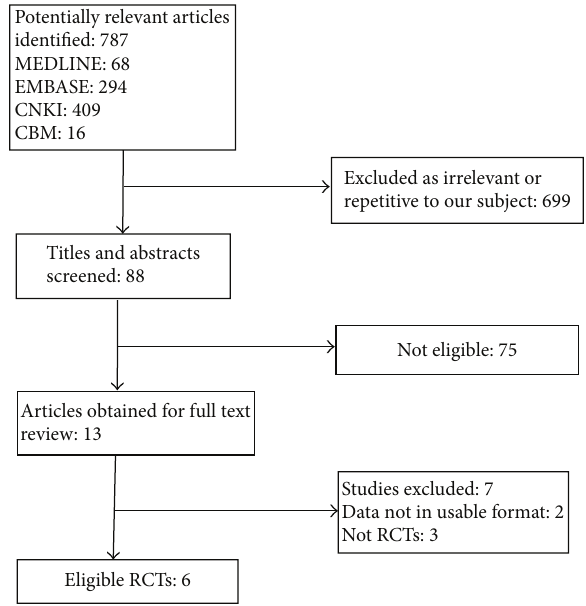
Figure 1: Flowchart of the trial selection process. RCT: randomized clinical